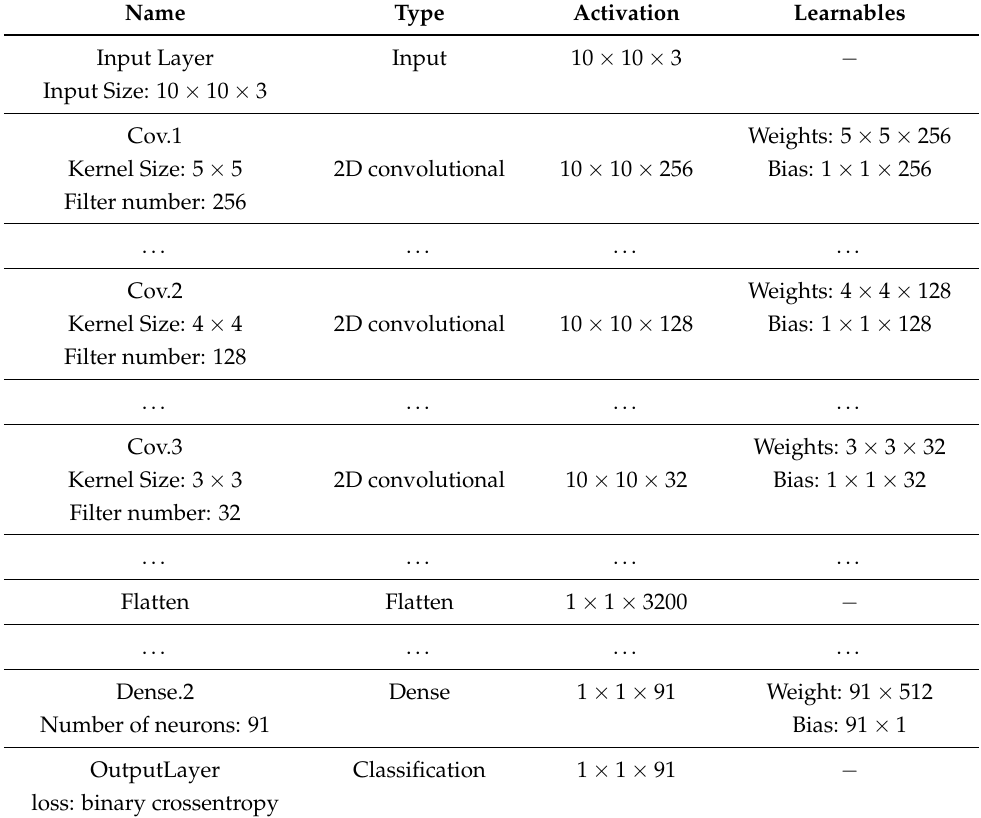
Table 3. Parameters of the range estimation